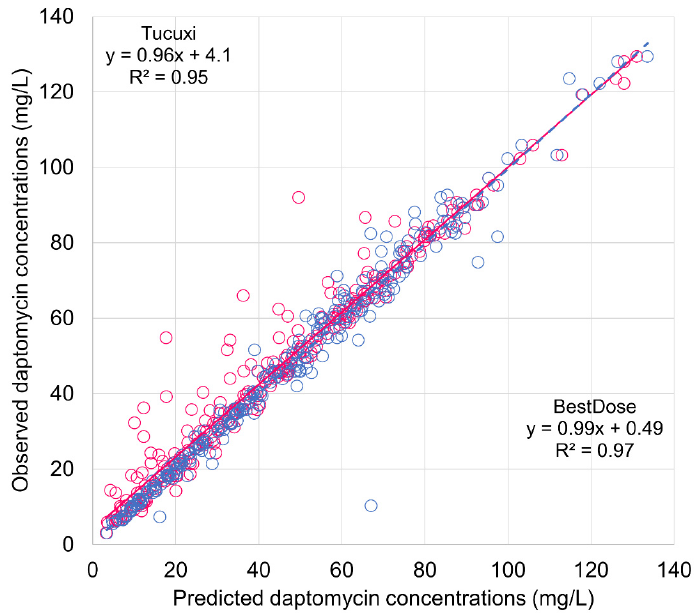
Figure 2. Observed plasma concentrations of daptomycin versus individual predictions from BestDose and Tucuxi in the validation dataset. Blue circles and dashed lines, BestDose predictions; red circles and solid line, Tucuxi predictions.